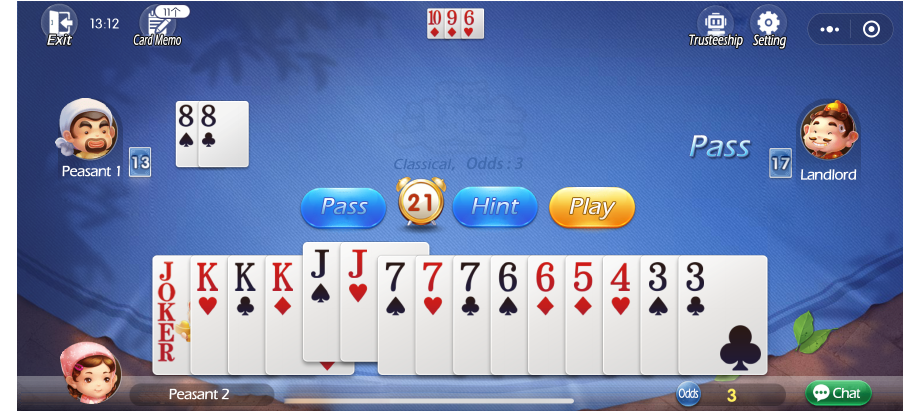
Figure 1. A screenshot of the Happy DouDiZhu